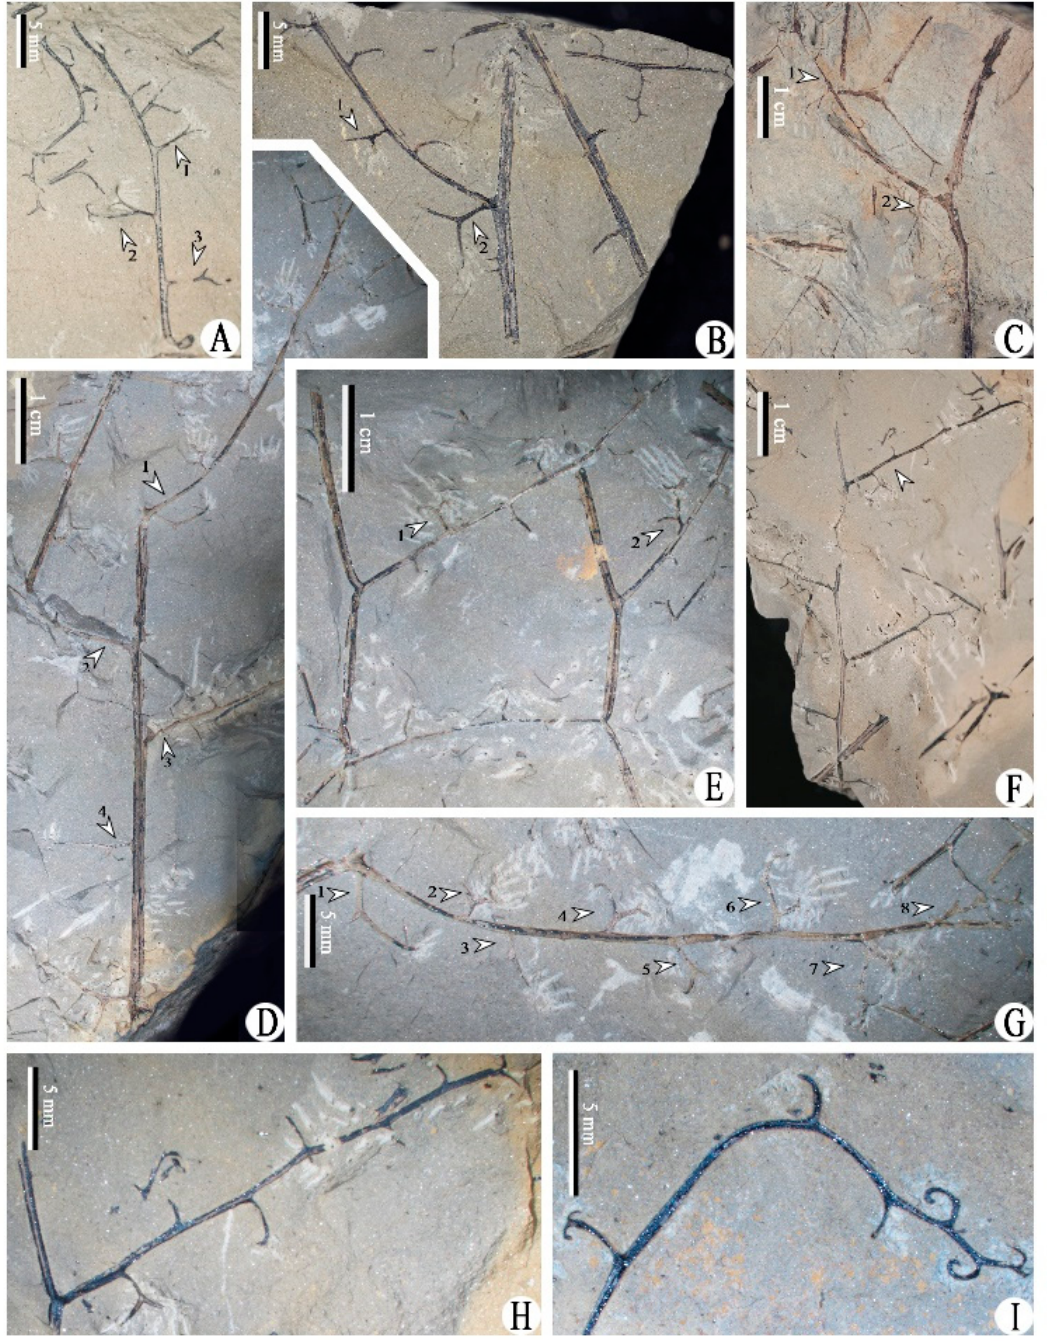
Figure 3. Morphology of Xinhangia spina gen. et sp. nov. from Guangde City, Anhui Province, China. ( A ) Secondary branch bearing vegetative ultimate appendages (arrows) in alternate arrangement. ( B , C ) Primary branch with secondary branch bearing vegetative ultimate appendages alternately. Arrow 1 in B indicates a dichotomized vegetative ultimate appendage. Arrow 2 in B and arrow 2 in C indicate aphlebia at the base of secondary branch. Arrow 1 in C indicates secondary branch. ( D – F ) Primary branch bearing secondary branches alternately. Arrows 1–4 in D and arrow in F indicate secondary branches. Arrows 1 and 2 in E indicate dichotomized vegetative ultimate appendages. ( G ) Enlargement of D (arrow 1) showing secondary branch bearing vegetative ultimate appendages alternately (arrows 2–8) and one aphlebia at base (arrow 1). ( H ) Enlargement of F (arrow) showing secondary branch bearing vegetative ultimate appendages alternately. ( I ) Upper portion of secondary branch bearing vegetative ultimate appendages alternately.